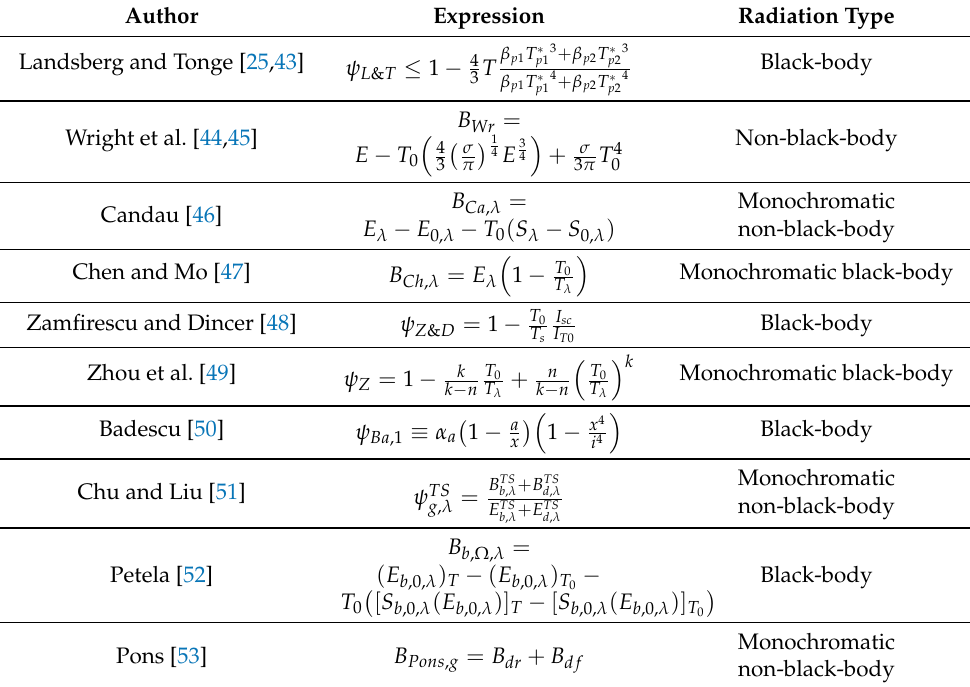
Table 2. Diluted solar exergy models where ψ is the exergy factor and B the exergy flux.